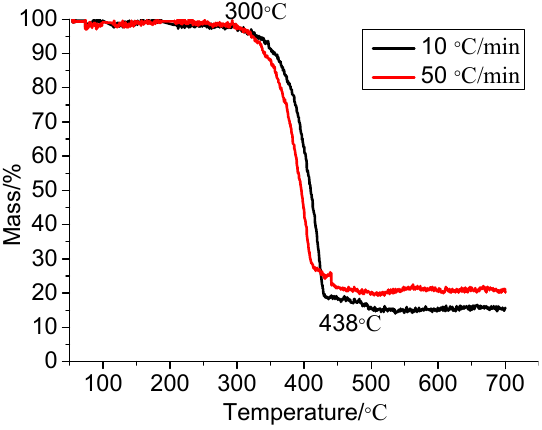
Figure 1. Thermogravimetry (TG) of Extruded polystyrene board (XPS panel).